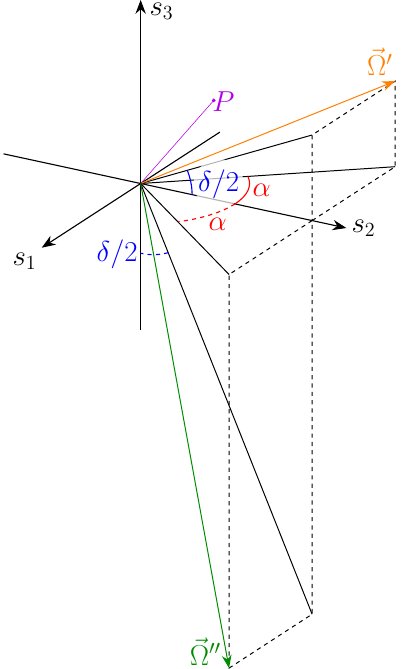
Figure 15. Rotation axes for the two solution sets.